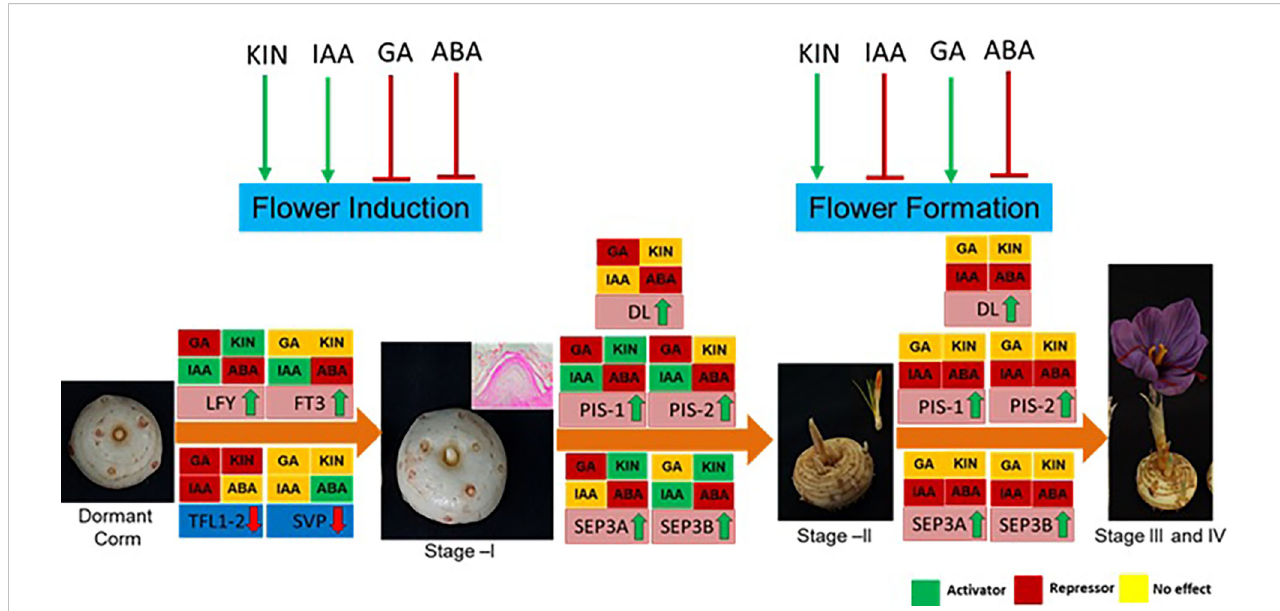
FIGURE 8 Summary of the effect of hormones on fl owering process, gene regulation, and their effect at different developmental stages of saffron fl owering. Brie fl y, ABA negatively regulates both fl ower induction and formation, whereas kinetin promotes both. Indole acetic acid (IAA) promotes fl ower induction, while gibberellic acid (GA) suppresses it. IAA inhibits fl ower formation, and GA promotes it. Green arrows show positive regulation, and red shows negative regulation. Hormonal effect on gene expression at different stages is marked by green, red, and yellow colors. The green color indicates induced expression levels, the red color indicates reduced expression levels, and the yellow color shows no signi fi cant changes in effect on the expression levels of the